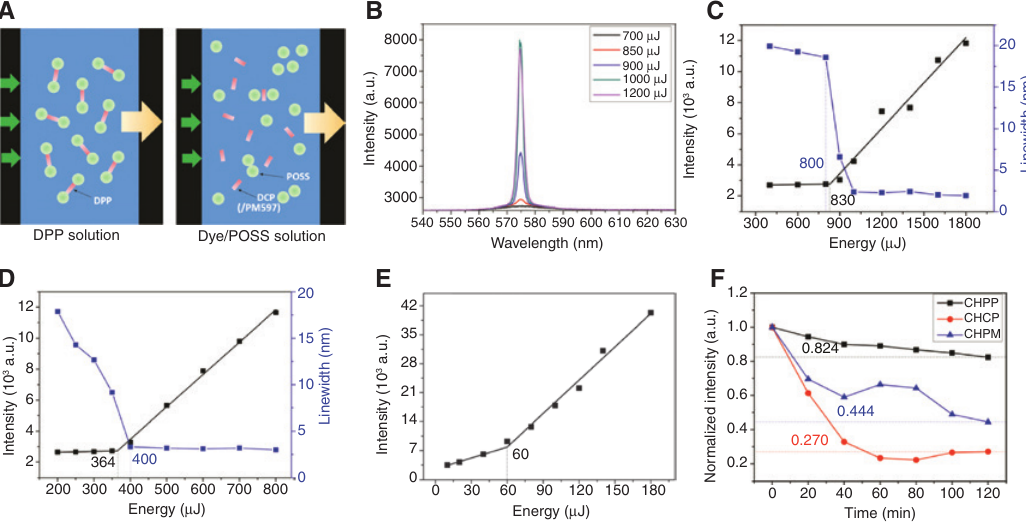
Figure 4: Random laser properties observed in the solution samples. Excitation-emission of CHPP, CHCP, and CHPM (A); Emission spectra of CHPP with different pumping energy (B); integrated emission inten- sity and corresponding FWHM as function of pumping energy for CHPP (C); POCP (D); POPM (E). Random lasing lifetime for CHPP, CHCP and CHPM (F). and DCP/POSS sample. This can be attributed to the fact occurrence of lasing emission. And the FWHM sharply that the scattering effect is so weak that the conditions decreases to 1.92 nm (3 nm) from 19.94 nm (17.87 nm) forming Anderson localization cannot be reached to gen- around the turning points for DPP (DCP/POSS), which erate coherent RL for DPP and DCP/POSS sample. In the implies that incoherent RLs have been observed in DPP